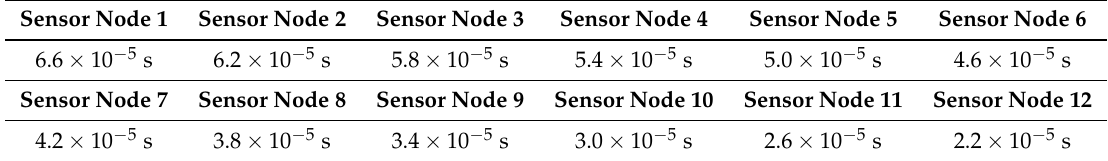
Table 3. The time delay of the sixth path of 12 sensor nodes.